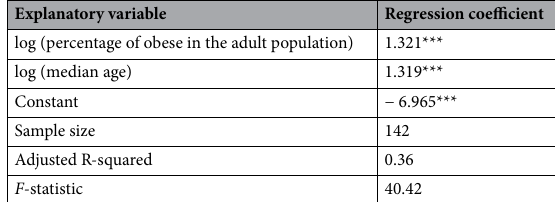
Table 1. COVID-19 Mortality and Proportion of Obese in Adult Population. Dependent variable is log of COVID-19 Mortality. ***indicates that a regression coefficient is statistically significant at 1% level.